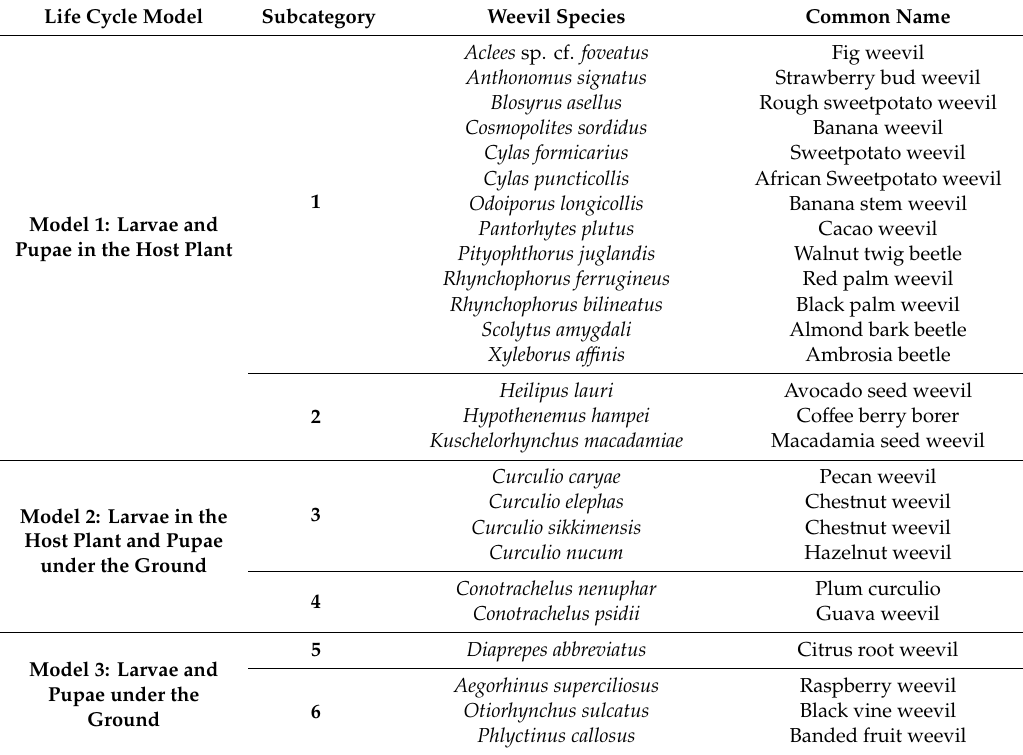
Table 3. Major horticultural weevil species used in experiments with EPF grouped according to their di ff erent life cycle habitat utilisation models. Subcategories 1–6 correspond to those shown in Figure